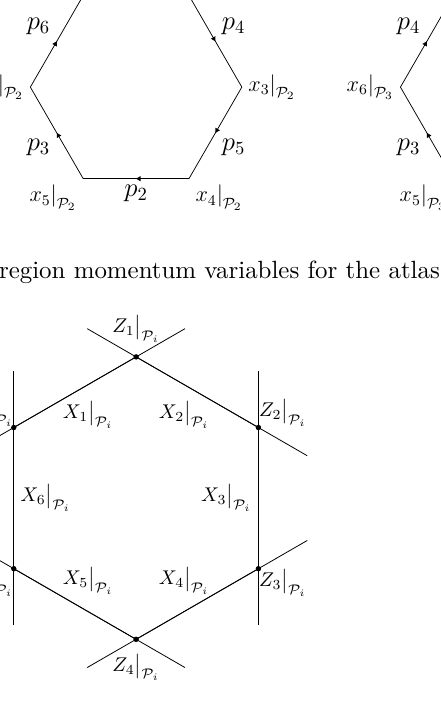
Figure 15 . Definition of momentum twistors from dual variables on a given patch P i